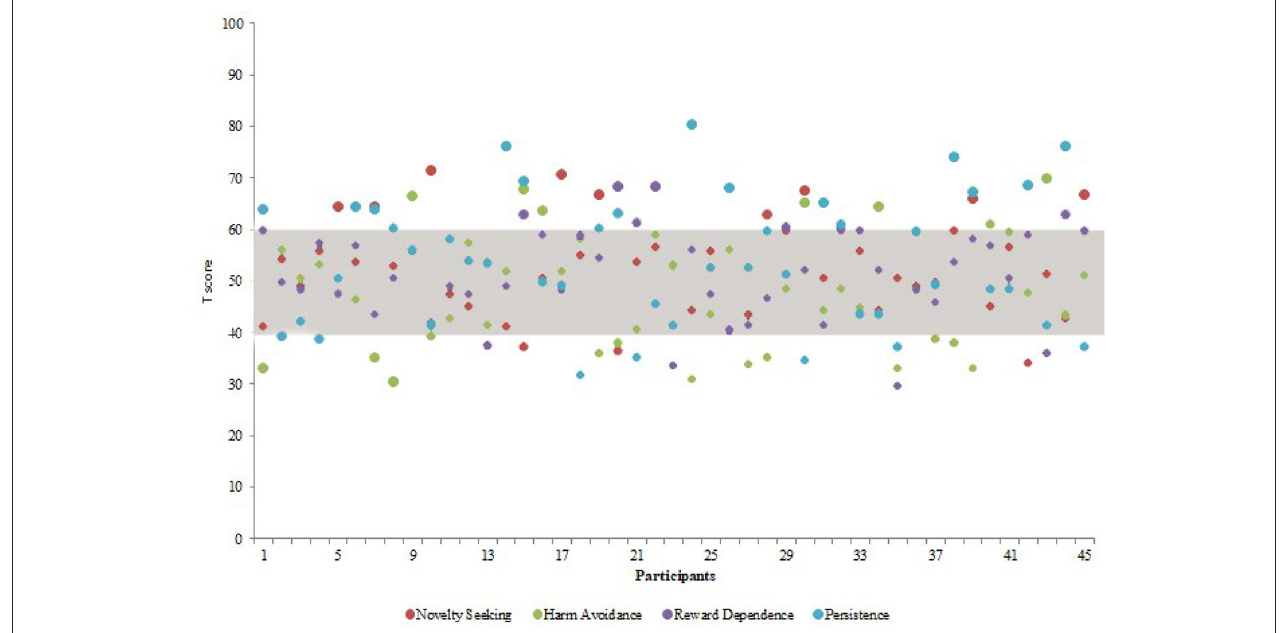
FIGURE 3 | T -score ( y -axis) relative to each temperamental trait (novelty seeking in red, harm avoidance in green, reward dependence in purple, and persistent in green) measured through the Temperament and Character Inventory-Revised for each participants ( x -axis). The gray area represents the medium range according to Martinotti et al. (2008).